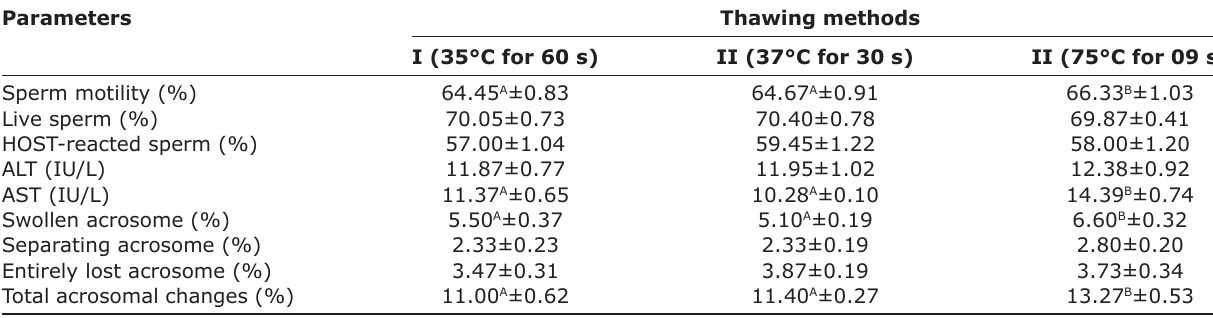
Table-1: Effect of different thawing methods on various post-thaw sperm parameters.